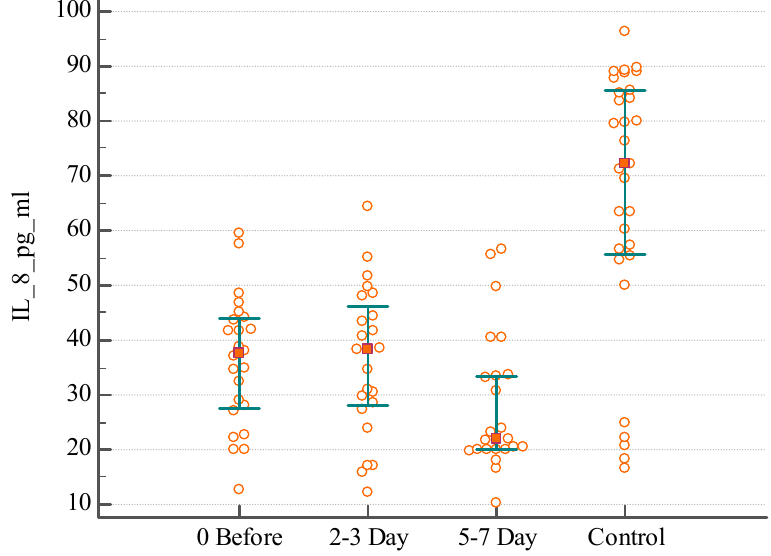
Figure 1. The distribution of serum IL-8 level in patients with postoperative abscesses before, and on the 2nd–3rd and 5th–7th days after surgical intervention.